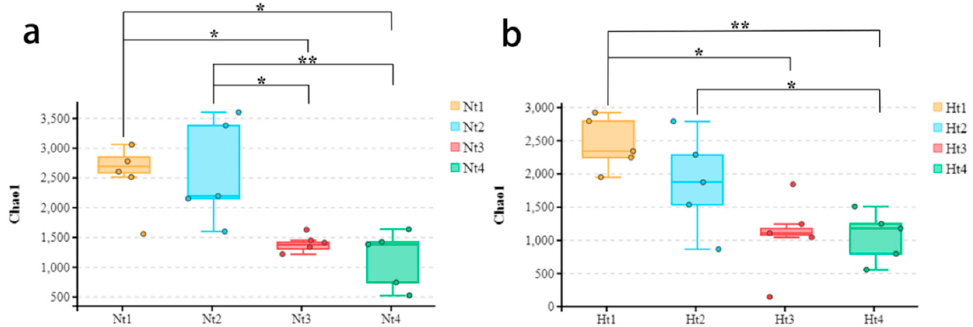
Figure 2. Chao1 diversity within both the Nt and Ht groups. ( a) Chao 1 indices at normal seawater temperature. ( b) Chao 1 indices at 3 °C higher temperature. Nt: normal seawater temperature. Ht: 3 °C higher temperature. 1, 2, 3, 4 represented samplings conducted in May, June, July and August, respectively. A single asterisk (*) indicated a significance level of p < 0.05, and a double asterisk (**) indicated a significance level of p < 0.01 .